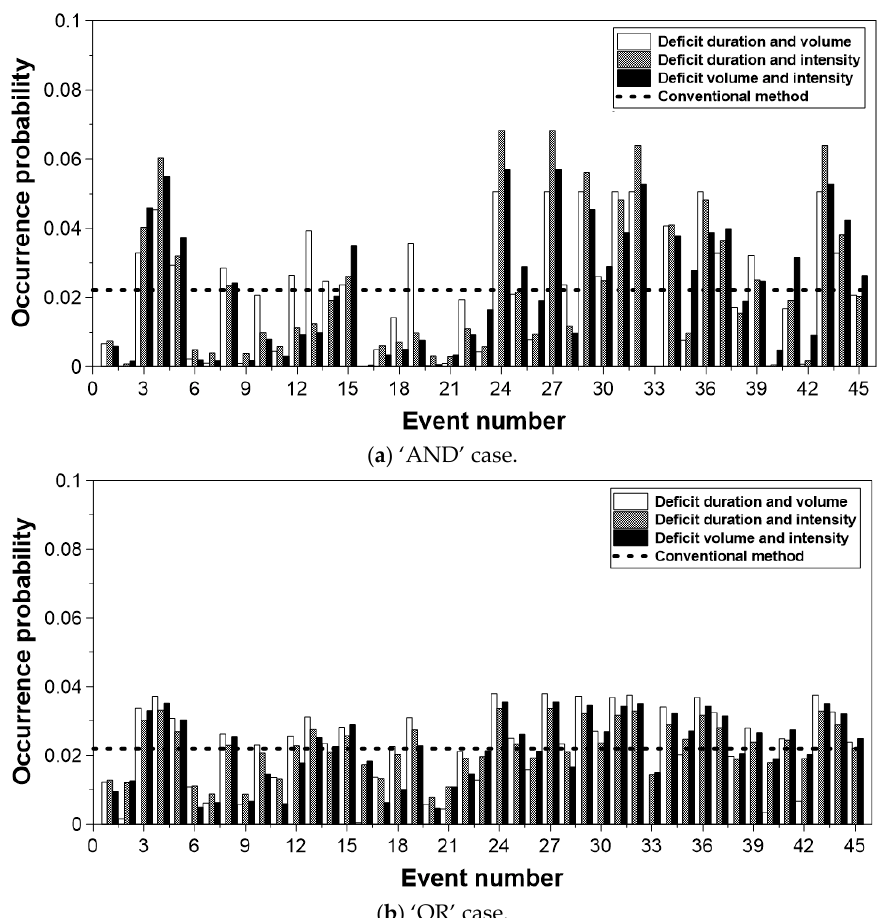
Figure 7. Comparison of normalized occurrence probabilities estimated for three different pairs of two variables constituting the water deficit events observed at the Namgang dam including for ( a ) the ‘AND’ case and ( b ) the ‘OR’